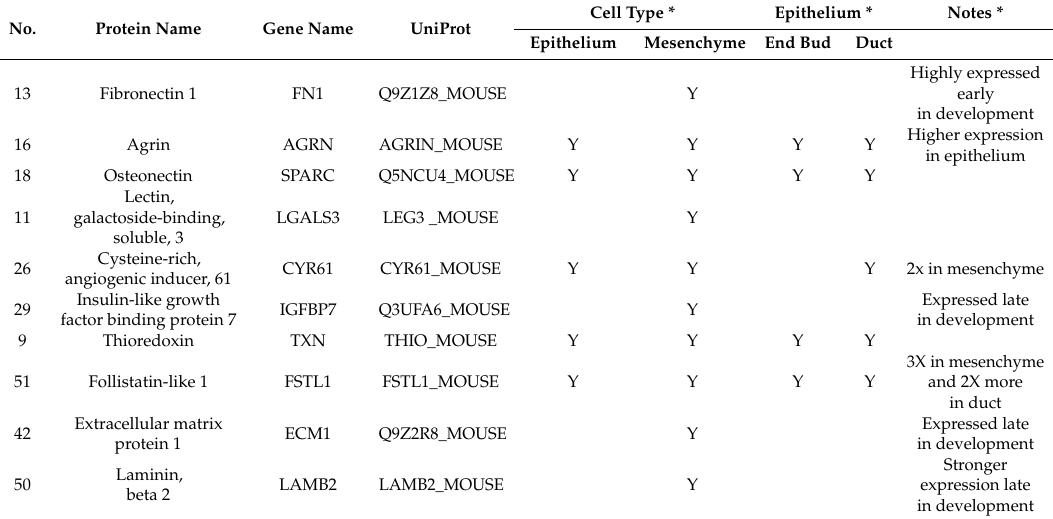
Table 3. List of ten secreted proteins in the MSC co-culture media at day 1, which are known to be involved in cell di ff erentiation and mouse salivary gland